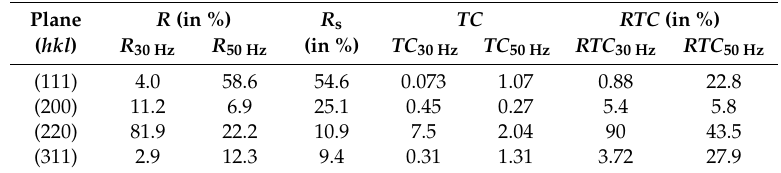
Table 2. Texture calculations for Cu coatings obtained by the PC regimes at frequencies of 30 and 50 Hz; s—Cu standard.